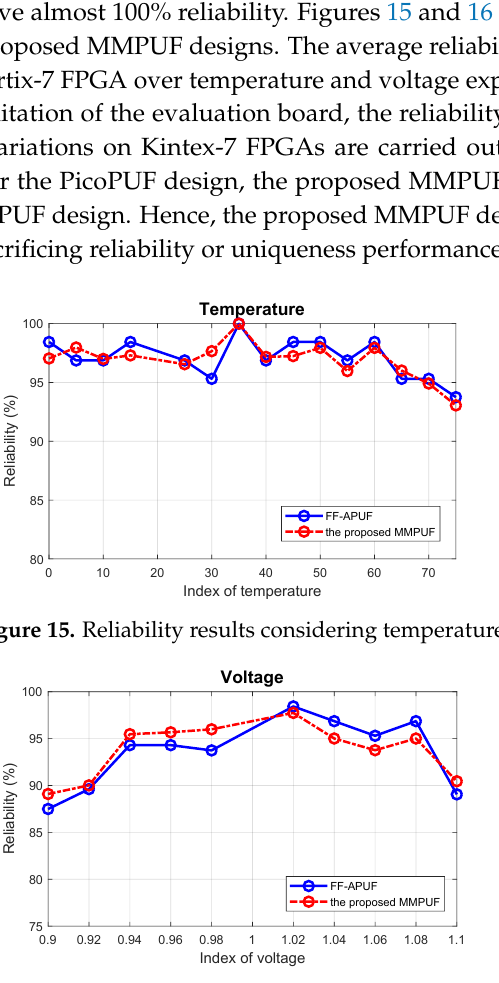
Figure 16. Reliability results considering